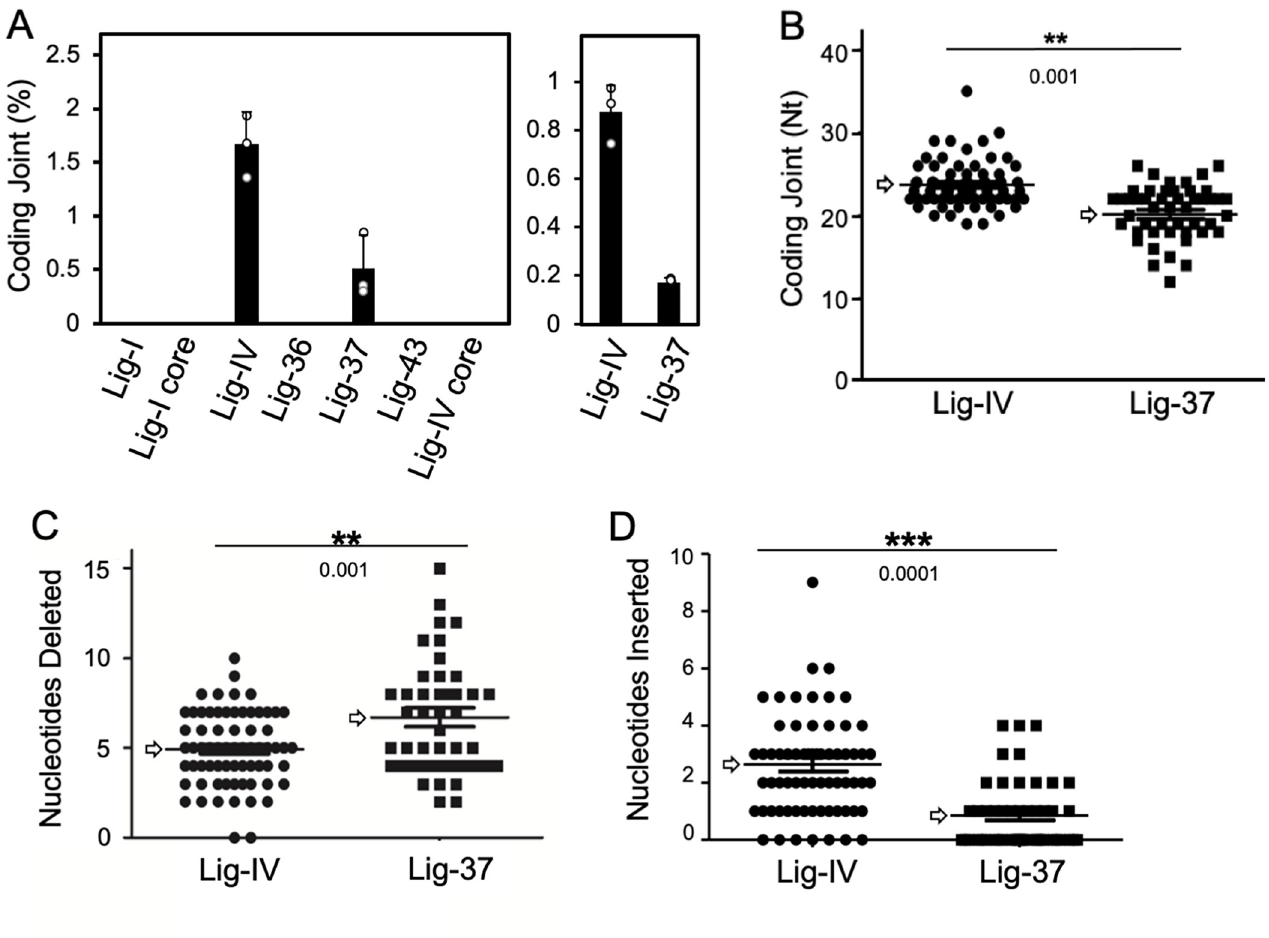
Fig 2. Chimeric protein Lig-37 supports formation of coding joints. A. Coding joint formation activity of chimeric ligases. Lig-IV-deficient human pre-B cells (N114P2) were transiently transfected with the following Flag-tagged expression vectors: Lig-I (50 ng), Lig-I core (50 ng), Lig-IV (3 μ g), Lig-36 (2.5 μ g), Lig-37 (7 μ g), Lig-43 (20 μ g) and Lig-IV core (20 μ g), along with the coding joint (CJ) substrate, pGG51. Two days post transfection, plasmid DNA was recovered and digested with DpnI restriction enzyme before transformation. Coding joint formation was determined by a colony formation assay as described [32]. Percentage of coding joint formation is presented on the y-axis. Error bars are from the evaluation of triplicates, with independent data points also depicted within the graph (white dots). An independent coding joint formation assay for Lig-IV and Lig-37 done with three biological replicates each is also presented (left side). For all other ligases that show no activity, the result from one experiment done with three biological replicates for each ligase is shown. However, the complete set of ligases was analyzed three times with three biological replicates in each independent experiment. B. Lig-37 mediates formation of shorter coding joints. Recombined plasmid DNA was extracted from Amp/Cam-resistant colonies and subjected to DNA sequencing. Sequencing results were analyzed, and total joint length was calculated and plotted. The length of coding joints formed with Lig-IV versus Lig-37 differed significantly in the number of nucleotides (Nt) at the junction, with the average joint length of Lig-37 shorter than that of Lig-IV. C and D . Lig-37 supports formation of coding joints with increased nucleotide deletion and decreased nucleotide insertion. For Fig 2B–2D, vertical scatter plots depicts individual coding joint lengths, nucleotide deleted, and nucleotides inserted respectively. For each data set, a two-tailed student’s t-test was performed and the p-values indicate a significant change between the values obtained in junctions isolated from Lig-IV versus Lig-37 transfected cells. White arrows within the graph highlight the mean value for each set of data